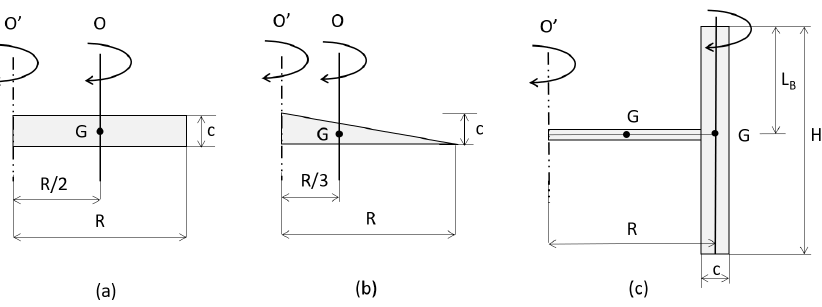
Figure 1. Simplified schemes of wind turbine rotors for HAWT with rectangular ( a ) and triangular ( b ) blade planform, as well as for H-VAWT ( c